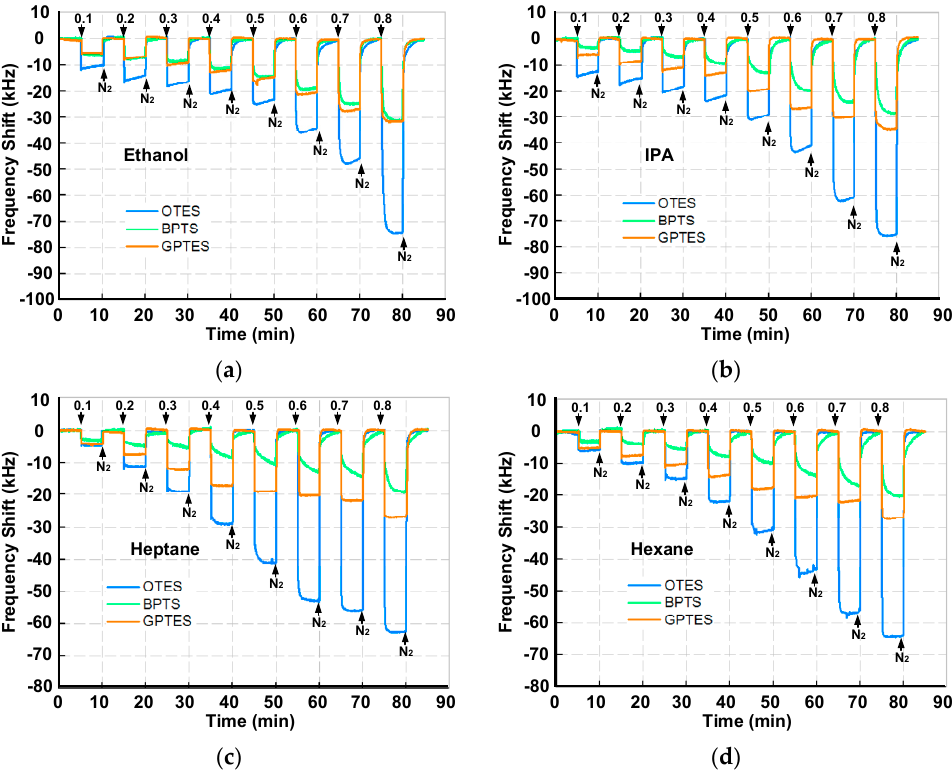
Figure 7. Real-time responses of the PSBAR array for detections of ( a ) ethanol, ( b ) IPA, ( c ) heptane and ( d ) hexane with gas partial pressures varying from 0.1 to 0.8.